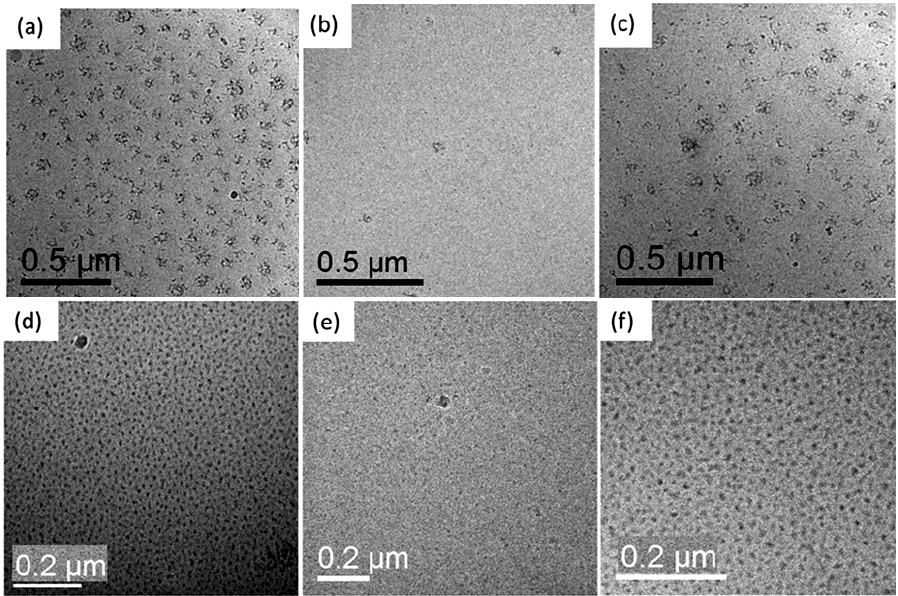
Figure 1. First raw: cryo-TEM images of the PLGASP20- b -PEO460 sample before UV irradiation ( a ), after after 5 min of UV irradiation ( b ) and after 180 min of visible irradiation ( c ). Second raw: cryo-TEM images of the sample PLGASP10- b -PEO235 sample before UV irradiation ( d ), after 5 min of UV irradiation ( e ) and after 180 min of visible irradiation ( f ). Reprinted with permission from [80]. Copyright (2011) American Chemical